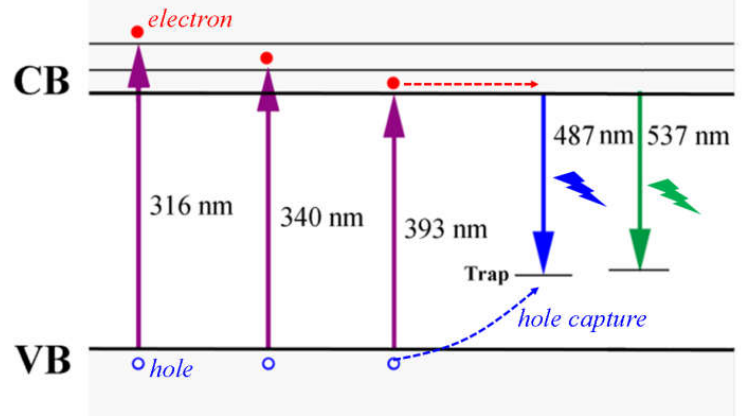
Figure 6. Photoluminescence (PL) process in τ-phase Ba 1.3 Ca 0.7 SiO 4 powder samples, suggesting the recombination should be related with the trap sites. Note that here, only hole traps were drawn for simplicity.